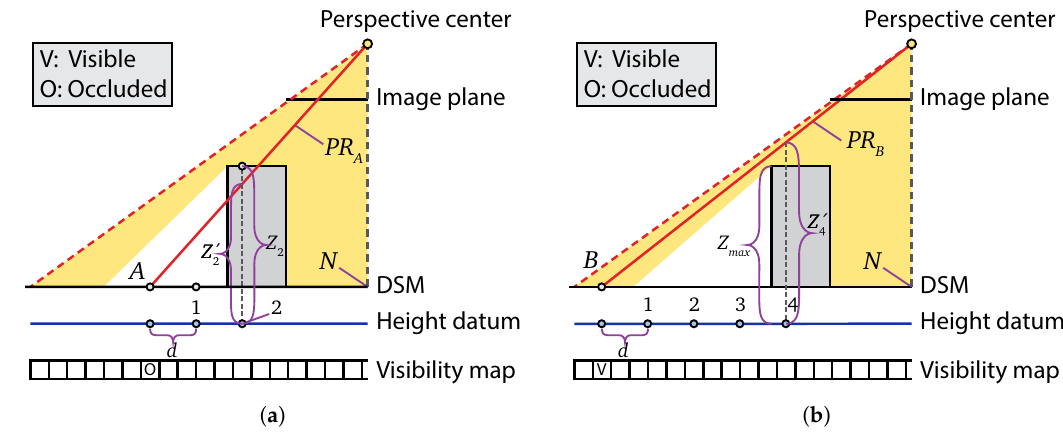
Figure 4. Principle of occlusion detection using the height-based